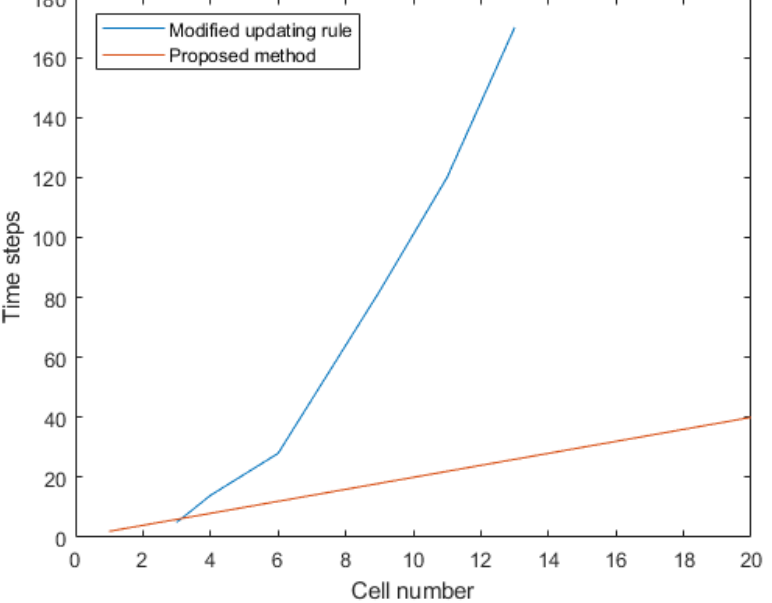
Figure 21. Configuration time of conventional (modified updating rule) and proposed (DSA-PSC) self-aligned phase-shifted carrier methods.